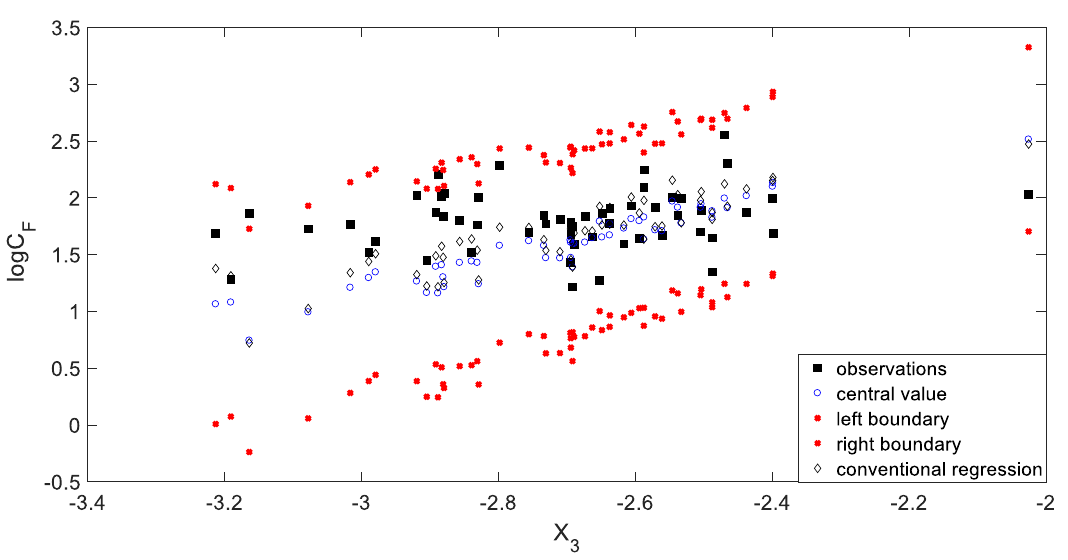
Figure 4. Multiple fuzzy regression of total sediment concentration in natural streams.